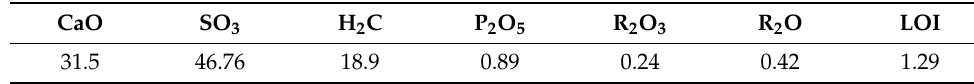
Table 4. Chemical composition of phosphogypsum, %.